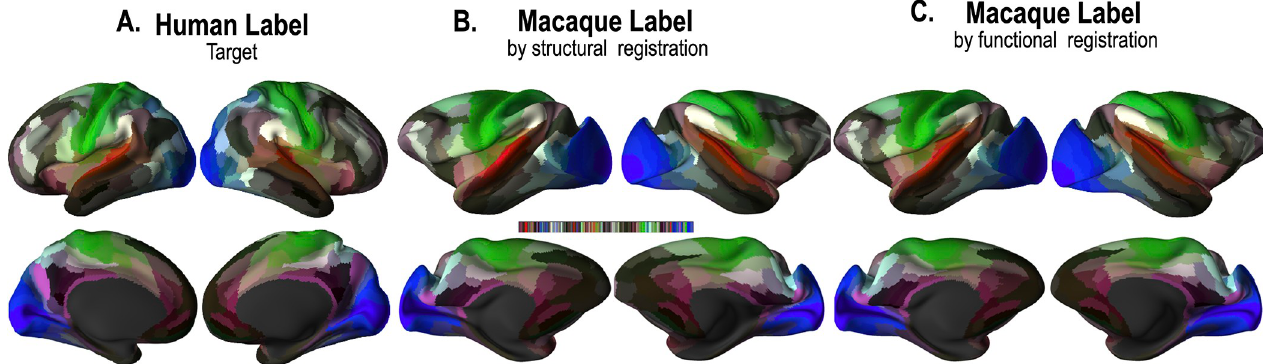
Fig 9. Parcellation maps of the human atlas and macaque atlas. (a) Parcellation map with 180 ROI labels of the human atlas. (b) Parcellation maps on the macaque atlas after registration using only structural features and (c) structural and functional network features.